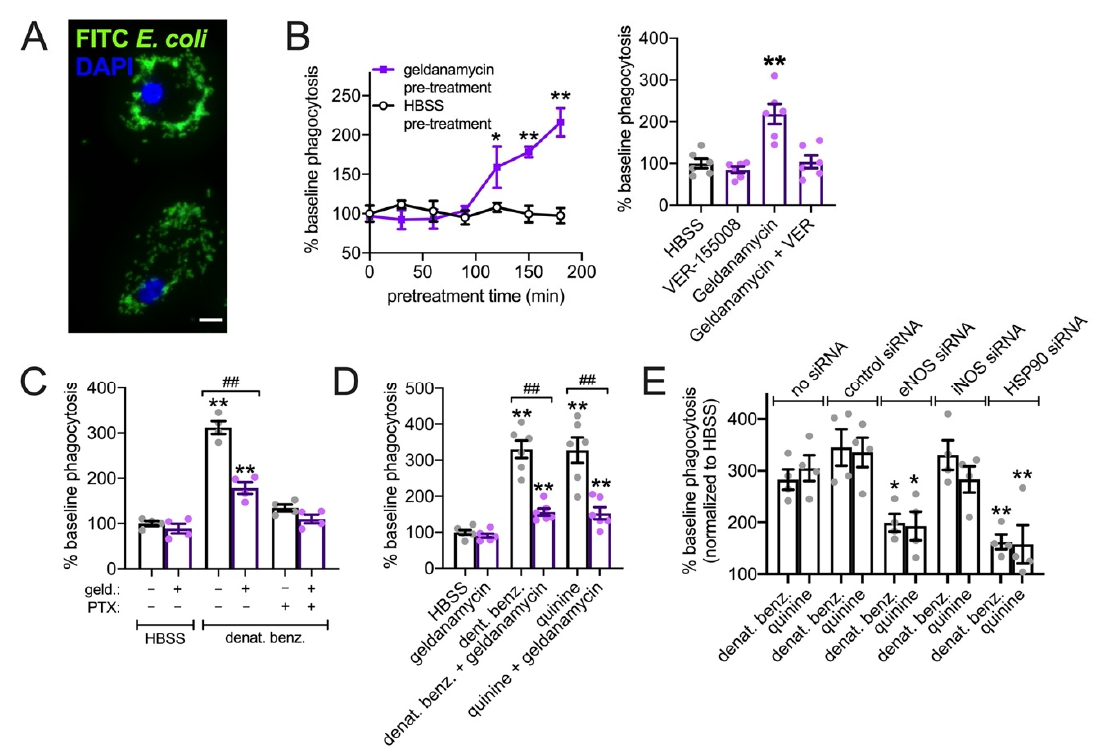
Figure 10. HSP90 inhibition reduces T2R-stimulated FITC- E. coli phagocytosis in primary human M0 M Φ s. ( A ): Representative image of M Φ s with phagocytosed FITC-labeled E. coli . ( B ): Left shows